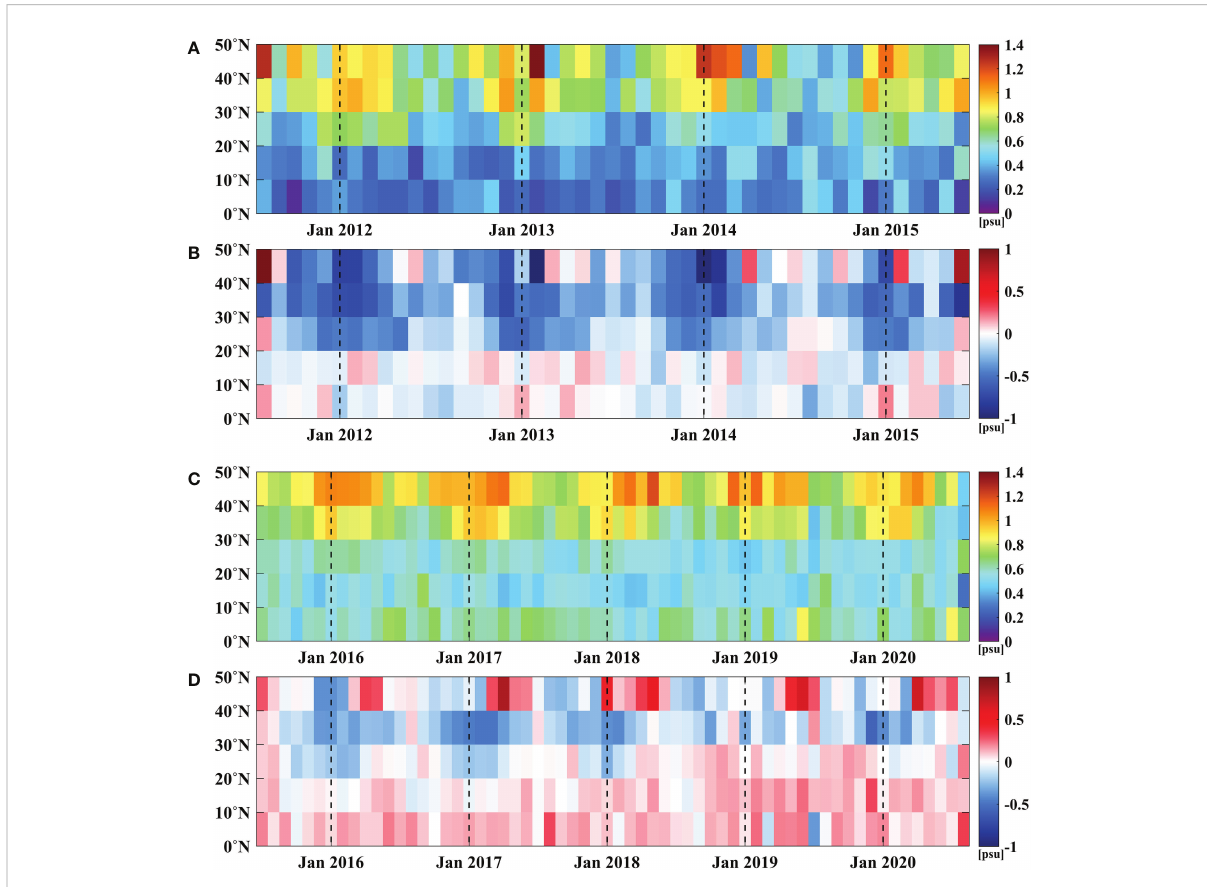
FIGURE 3 Latitude-time plots of (A) root mean square error (RMSE) and (B) bias of Aquarius sea surface salinity (SSS) (psu) as compared to the in situ salinity measurements in the Northwest Paci fi c Ocean from August 2011 to June 2015. (C) and (D) are the RMSE and bias of the Soil Moisture Active Passive (SMAP) SSS data from April 2015 to August 2020,